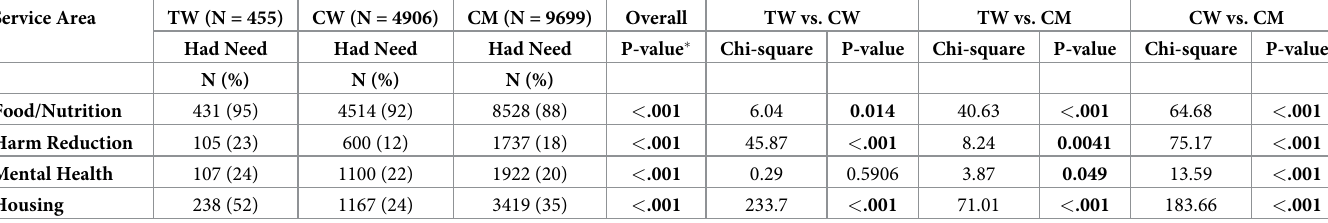
Table 3. Ryan White Part A service category need by gender. Service